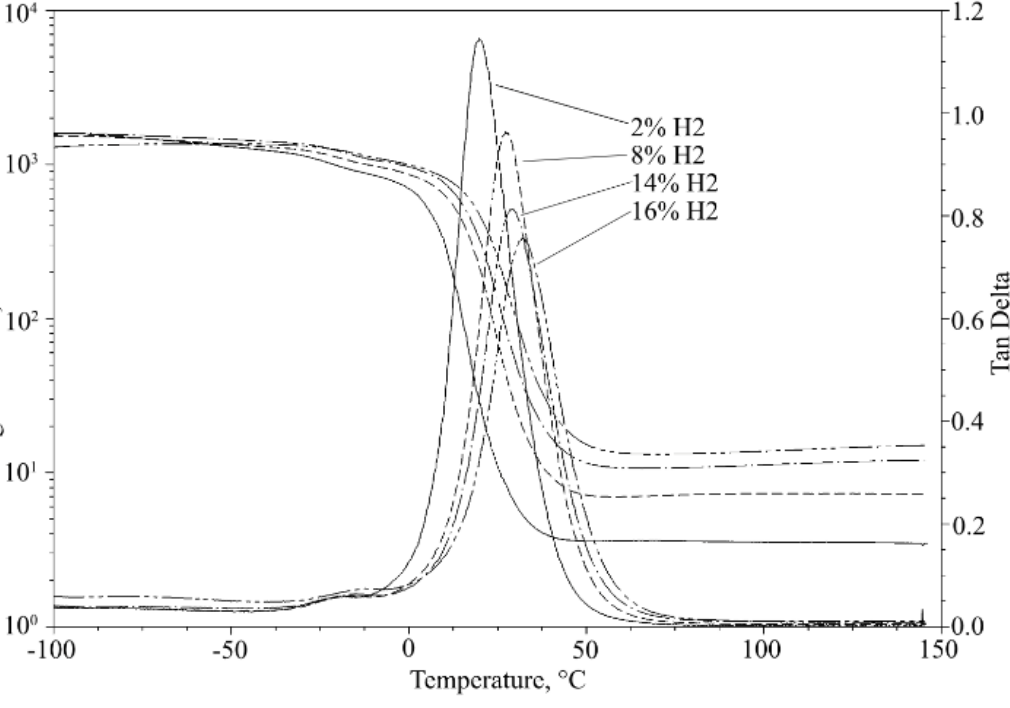
Figure 4. Storage modulus (left axis, rounded step curves) and 'tan delta' (right axis, peaked curves) of H2 composites. The upper plateau of the storage modulus curves is the ‘glassy’ region; the lower plateau (at higher temperatures) is the ‘rubbery’ region. The peak in 'tan delta' is the glass transition (T